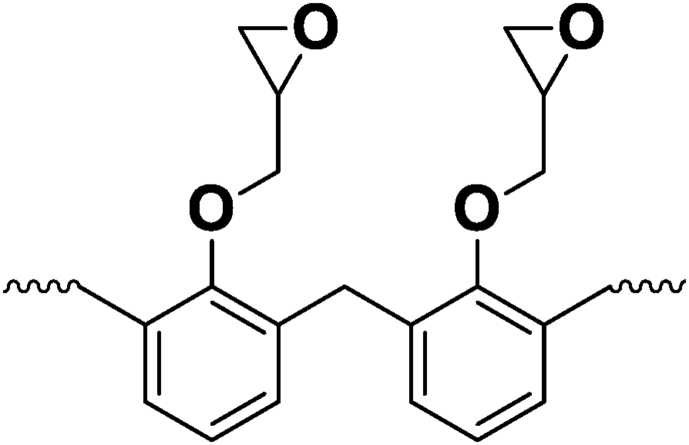
Structure of NEP [23, 24].